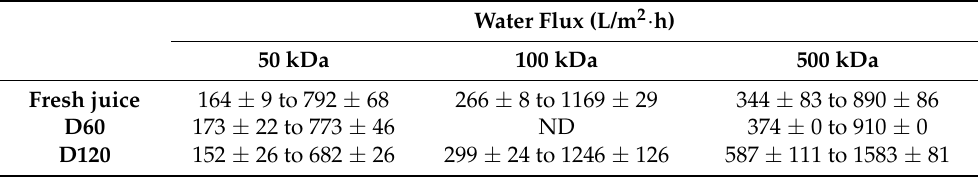
Table A1. Pure water fluxes of 50, 100 and 500 kDa UF membranes measured for transmembrane pressure ranging from 15 to 95